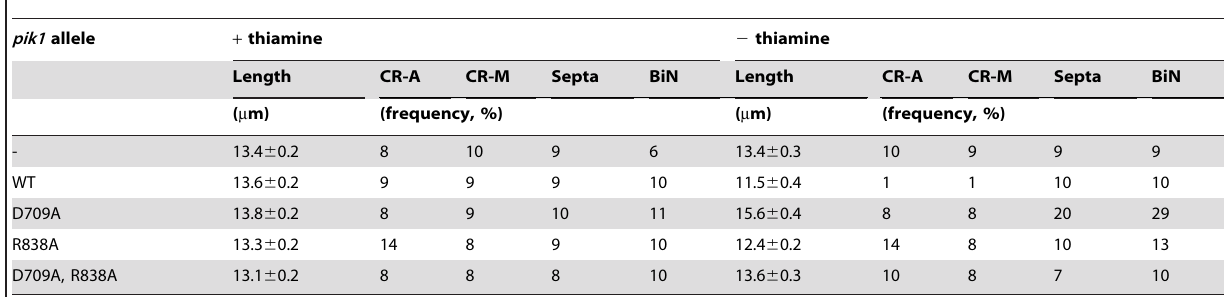
Table 3. Effects of ectopic expression of pik1 alleles on cytokinesis in cdc4 cells.